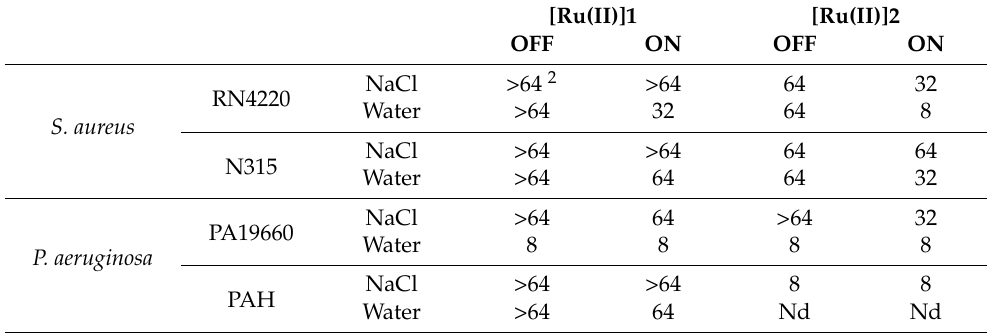
Table 1. MIC 1 of [Ru(II)] following light treatment performed either in water or in 1X